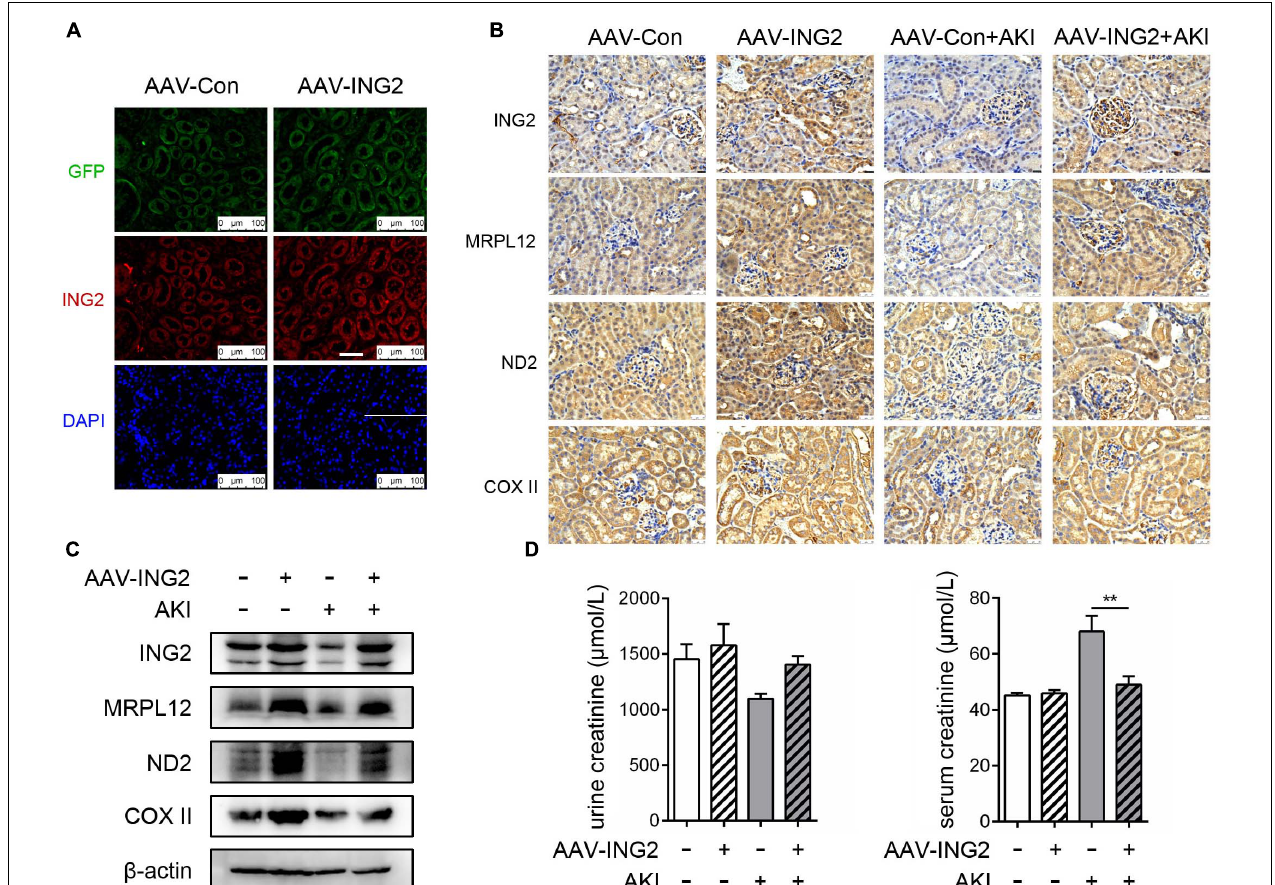
FIGURE 5 | ING2 overexpression effectively ameliorated ischemic kidney injury. The mice were injected with rAAV-con or rAAV-ING2 followed by the induction of IRI with sham operation group as control. (A) Immunofluorescent staining of kidneys after the intra-renal injection of rAAV vectors with ING2 (red) and DAPI (blue). (B) Immunostaining of renal tissue sections with antibodies against ING2, MRPL12, ND2, and COX II. (C) Western blot analysis of renal tissue ING2, MRPL12, ND2, and COX II. (D) Levels of creatinine in the serum or urine of IRI and sham operation mice. Data were from two individual experiments and presented as mean ± SEM. rAAV-con + IRI, n = 6; rAAV-ING2 + IRI, n = 6; rAAV-con + sham, n = 4; rAAV-ING2 + sham, n = 4. ** p < 0.01. ns, not significant.